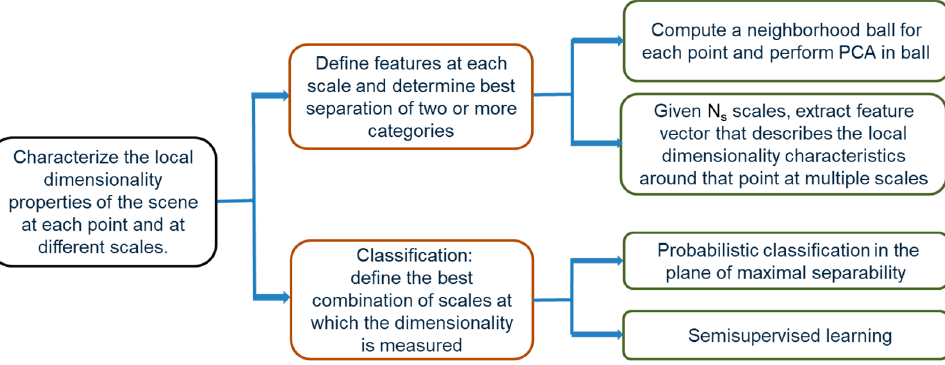
Figure 2. The classification algorithm of the scene elements based on their 3D geometrical properties across multiple scales.